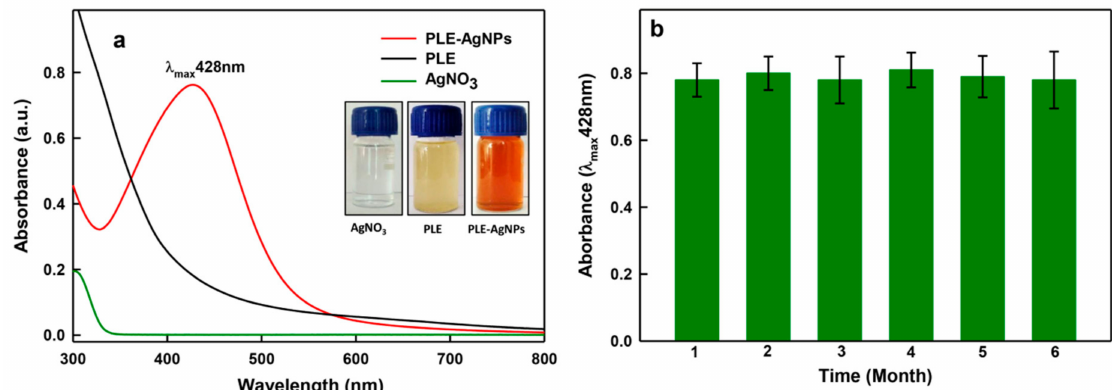
Figure 1. UV-Vis analysis of nanoparticles (NPs). Panel ( a ) demonstrate UV-Vis absorption peaks of pristine poly-herbal bio-actives in Liv52 extract (PLE), AgNO 3 and LIV-AgNPs. Panel ( b ) shows stability of PLE capped silver NPs (LIV- AgNPs) based on surface plasmon resonance (SPR) measurements up to six months (error bars represent the mean ± SE of three